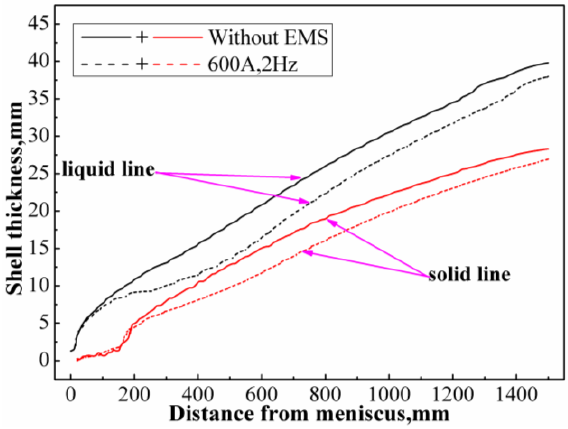
Figure 12. Liquid and solid distributions at the y – z plane along the casting direction for different cases.